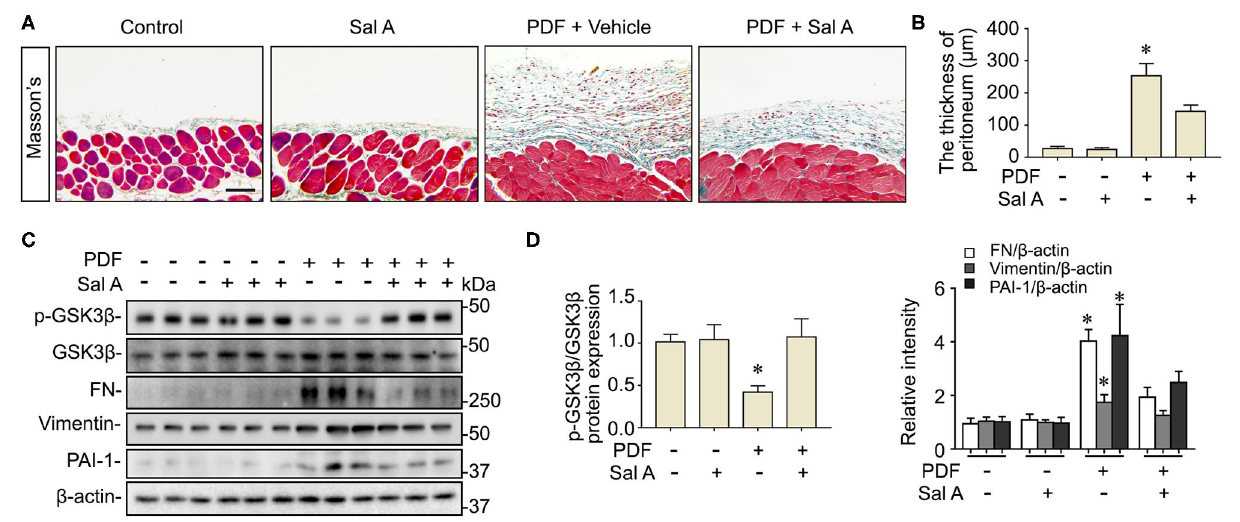
FIGURE 2 | Sal A treatment ameliorates peritoneal fibrosis and averts GSK3 β hyperactivity in the murine model of peritoneal dialysis. (A) Mice were randomized to receive daily intraperitoneal injection of 3ml of 4.25% dextrose PDF or PBS in the presence of daily intraperitoneal injection of Sal A or vehicle. The peritoneal tissues were collected 7 weeks later and subjected to Masson’s trichrome staining. Scale bar = 100 µ m. (B) The thickness of the submesothelial compact zone was estimated by computerized morphometric analysis and data were expressed as mean ± SD and were analyzed by one-way ANOVA followed by Tukey’s test. * P < 0.05 vs. all other groups ( n = 6). (C) Representative immunoblots showing immunoblot analysis of peritoneal tissues for indicated molecules. (D) Relative abundance of indicated proteins, as normalized to the expression of β -actin or total GSK3 β based on densitometric analyses of immunoblots ( n = 6). Data were analyzed by one-way ANOVA followed by Tukey’s test. * P < 0.05 vs. other